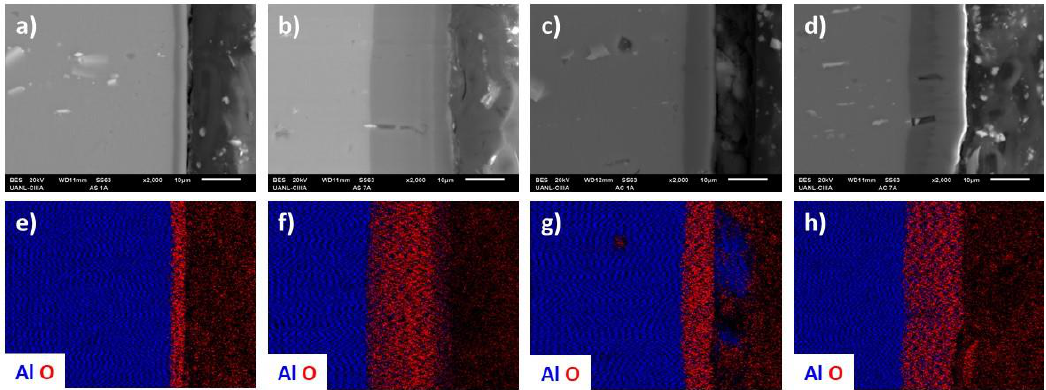
Figure 6. SEM cross-sectional micrographs and element mapping of the anodized samples in sulfuric acid solution and mixture of citric–sulfuric acid solution. ( a , e ) SA (sulfuric acid) / 1 A · cm − 2 ; ( b , f ) SA (sulfuric acid) / 7.2 A · cm − 2 ; ( c , g ) CA (citric acid) / 1 A · cm − 2 and ( d , h ) CA (citric acid) / 7.2 A · cm − 2 .